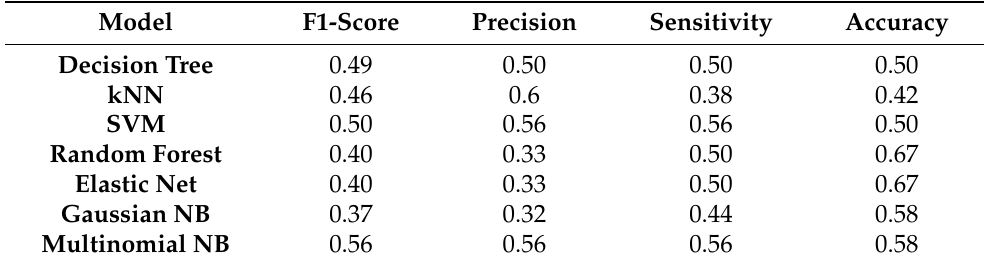
Figure 11. PPA vs. CG in PCA two dimensions. Table 4. Metrics from classification models for PPA vs. CG using all columns (with no feature